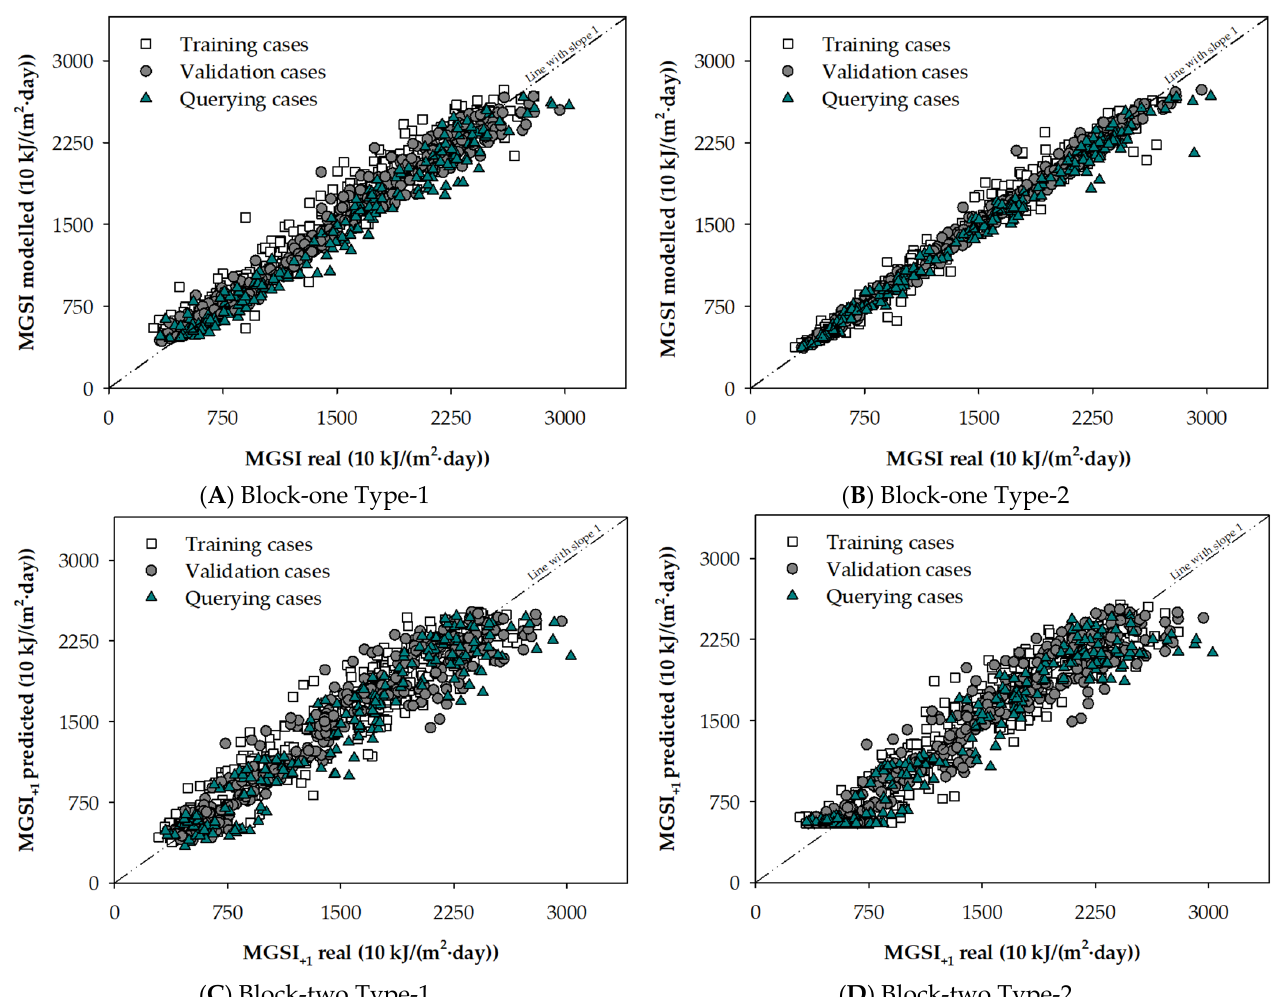
Figure 2. Scatter plot for the real and modelled/predicted values of MGSI for the training (white squares), the validation (grey dots) and the querying cases (cyan triangles) for each ANN selected model using the combination of the variables to model the MGSI (Block-one Type-1 ( A ) and Block-one Type-2 ( B )), and to predict MGSI one month ahead (Block-two Type-1 ( C ) and Block-two Type-2 ( D )). Dashed and dotted line is the line of slope one. Adapted from Puga-Gil (2022)